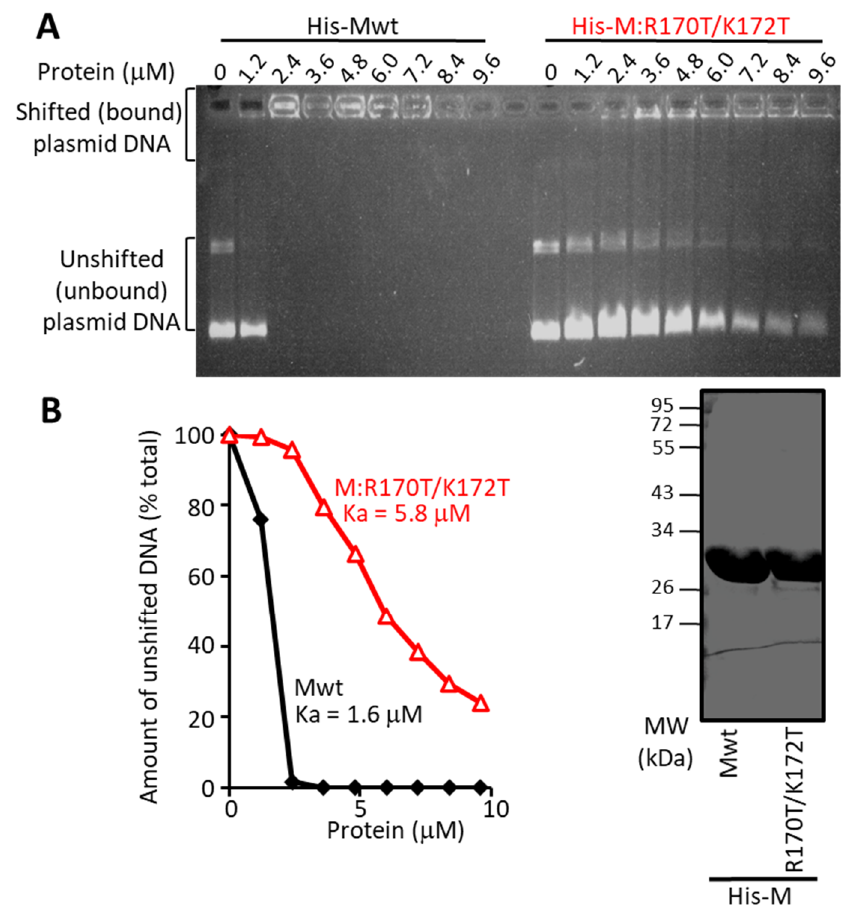
Figure 4. M can bind DNA in vitro dependent on residues R170 and K172. ( A ) Increasing concentra- tions of purified His-Mwt or His-M-R170T/K172T protein were incubated with 200 ng plasmid DNA (6.84 Kb) for 15 min at room temperature, and the protein-DNA complexes electrophoresed on an 0.8% agarose gel in the absence of ethidium bromide for 8 h at 4C. The gel was then stained with ethidium bromide solution (1 µg/mL) for 15 min, washed with water for 5 min and then imaged. ( B ) The levels of unshifted (unbound) DNA from ( A ) were quantified using the NIH ImageJ software, with results expressed as a percentage of the value in the absence of M protein. Association constants (Ka) estimated from the curves are indicated. Results are typical for a series of analogous experiments. Right: Coomassie blue stained SDS –PAGE gel of purified His-M proteins (4 µ g/lane) used in ( A ). Running positions of molecular weight standards are shown on the